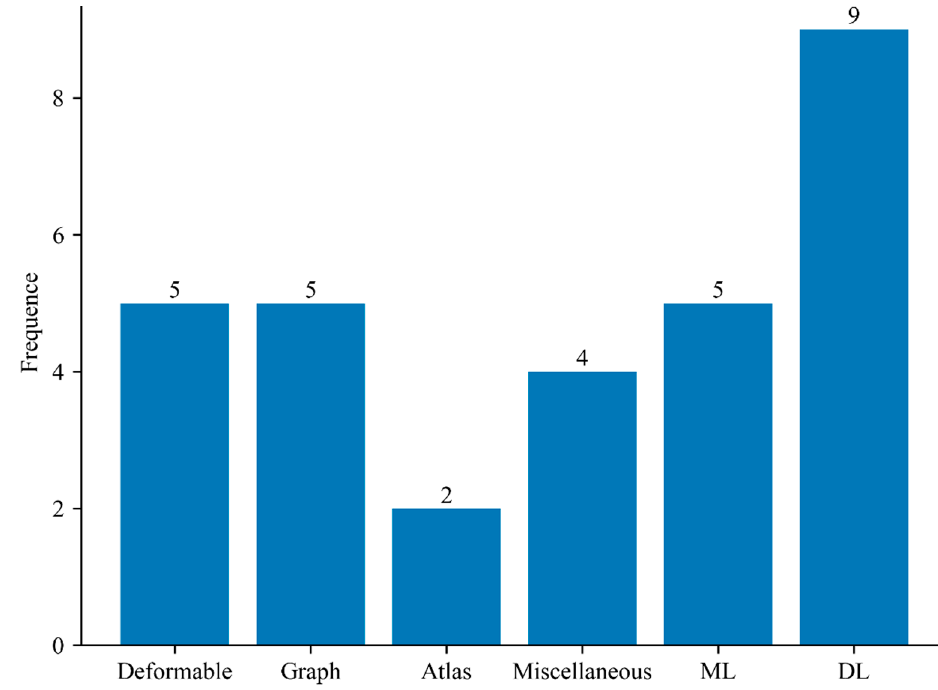
Figure 14. Demonstration of the number of papers reviewed for each method in KOA studies.